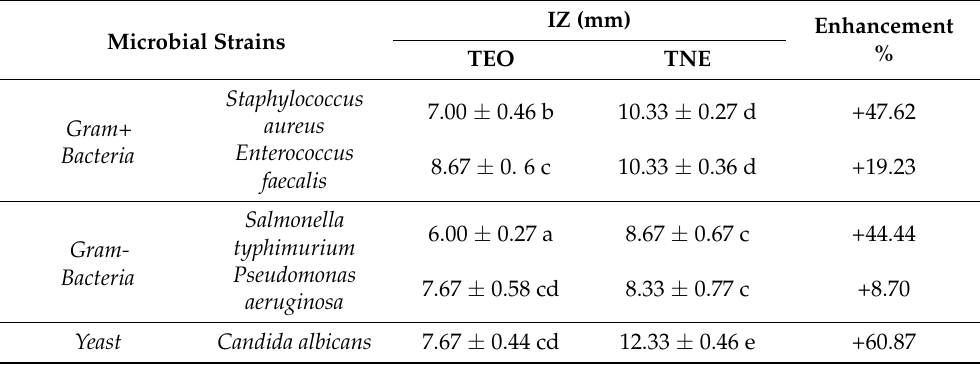
Table 4. Growth inhibition zones (IZ, expressed in mm) were obtained with the bulk (TEO) and nanoencapsulated (TNE) T. capitatus EO (33 mg/mL) against five microbial strains. Values followed by different letters mean statistically significant differences ( p <